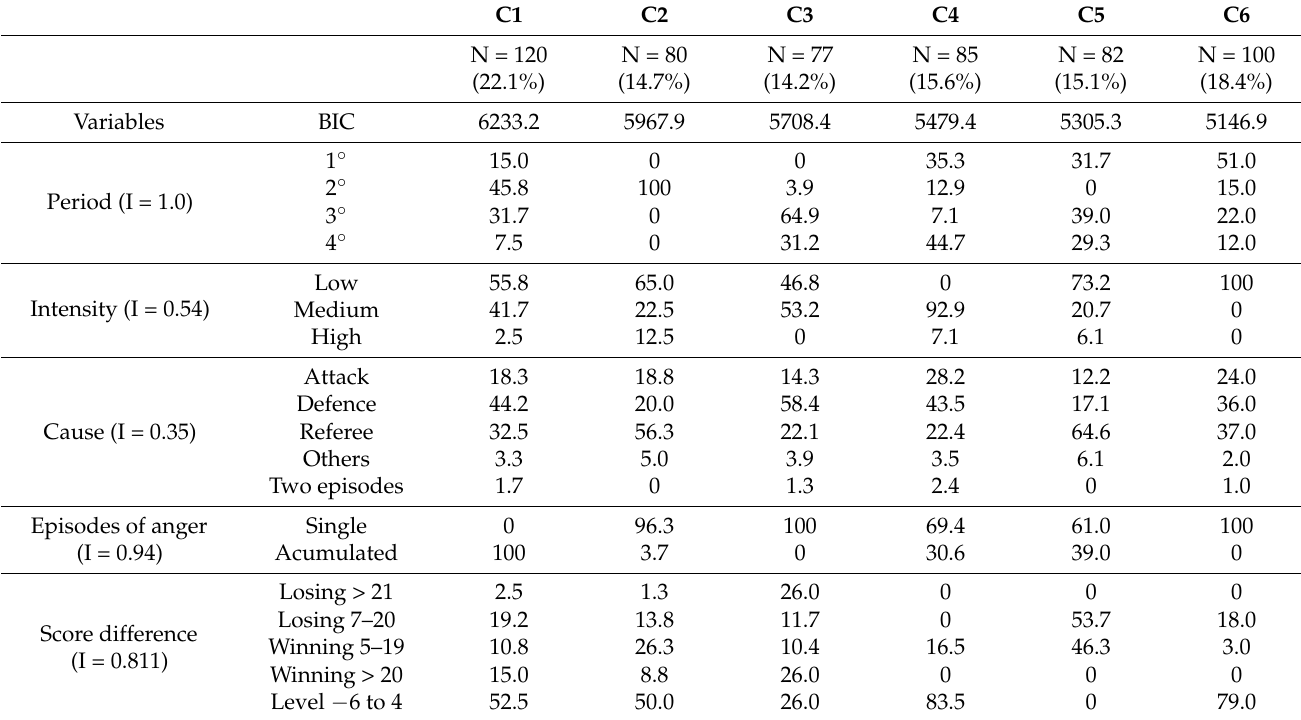
Table 1. Cluster obtained via the two-stage method for the contextual variables related to the episode of anger (values in %